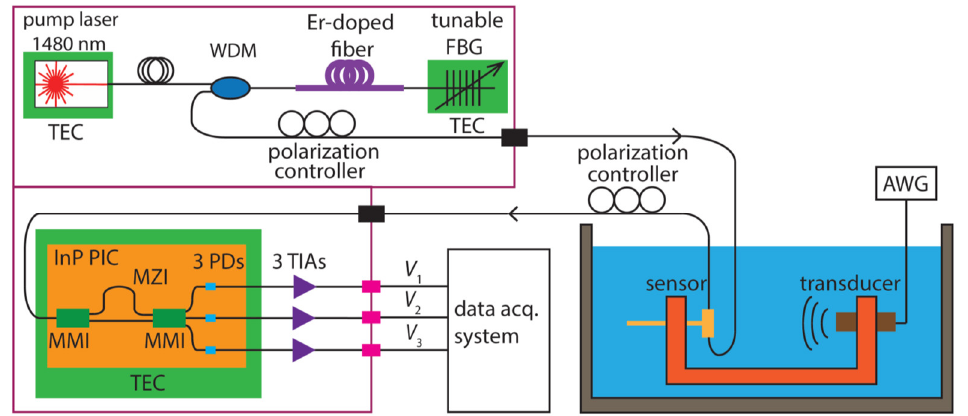
Figure 13. MediGator ( left ) and experimental setup ( right ). The MediGator comprises the tunable light source of high brightness ( upper part) and the photonic integrated circuit of MZI and PDs ( lower part). Each PD is connected to a TIA. (TEC, thermoelectric cooling; WDM, wavelength division multiplexer; FBG, fiber Bragg grating; PIC, photonic integrated circuit; PD, photodetector; TIA, trans-impedance amplifier; AWG, arbitrary waveform generator; MMI, multi-mode interferometer) [190].